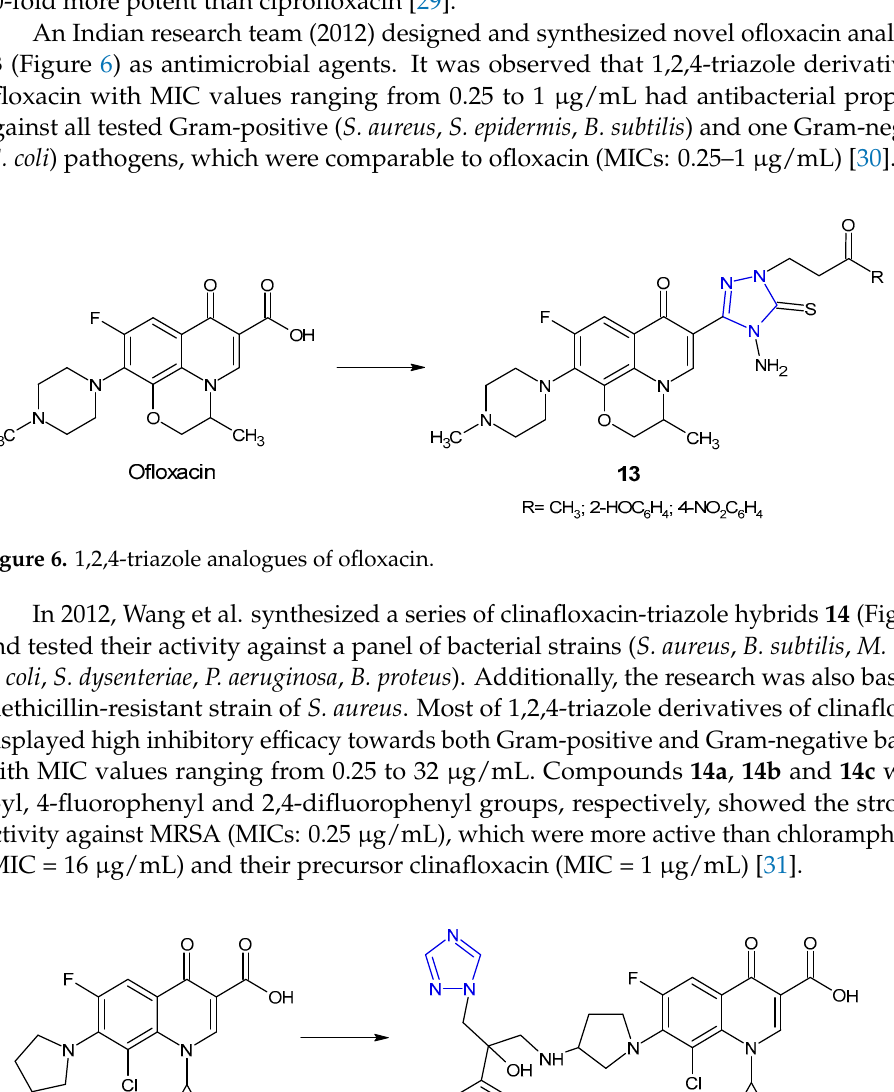
Indian researchers (2010) reported a synthesis of 4-amino-5-aryl-4 H -1,2,4-triazole derivatives 15 (Figure 8) and screened for in vitro antibacterial properties against E. coli , B. subtilis , P. aeruginosa and P. fluoroscens (recultured). Compound with 4-trichloromethyl group attached to the phenyl ring at the 3-position of triazole was observed to exhibit the highest antibacterial activity (MIC = 5 µg/mL and the zone of inhibition 14–22 mm), equivalent to ceftriaxone, while compounds containing 4-chloro and 4-bromo substituents showed good activity. Acetylation of the NH 2 group at the 4-position and the presence of the free SH group at the 3-position of triazole caused a decrease in antibacterial activity against most bacterial strains [32]. Figure 8. Antibacterial derivatives of 4-amino-1,2,4-triazole. Muthal et al. (2010) synthesized 5-substituted-3-pyridin-4-yl-1,2,4-triazoles 16 (Figure 8) as antibacterial and anti-inflammatory agents. In vitro assay indicated that compound with 4-hydroxyphenyl moiety inhibited the growth of all bacteria ( B. subtilis, S. aureus, P. mirabilis and S. typhi ) to the extent comparable to levofloxacin (zones of inhibition of the compound—26–27 mm, compared to 28 mm for levofloxacin). Proteus mirabilis was most sensitive to all tested compounds. Additionally, the selected compounds showed moderate anti-inflammatory activity in a carrageenan-induced rat paw oedema model [33]. In 2013, Gadegoni et al. reported synthesis and antibacterial activity of 3-[4-amino-3- (1 H -indol-3-yl-methyl)-5-oxo(5-thioxo)-4,5-dihydro-1,2,4-triazol-1-yl]-propionitriles